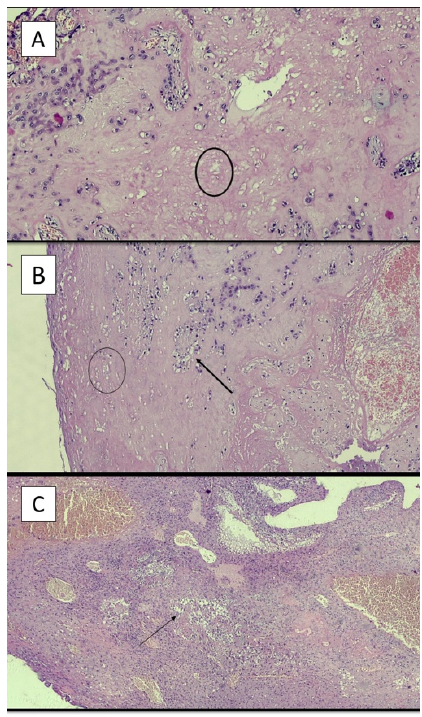
Figure 3A–C refers to examples of different time of onset of LN.